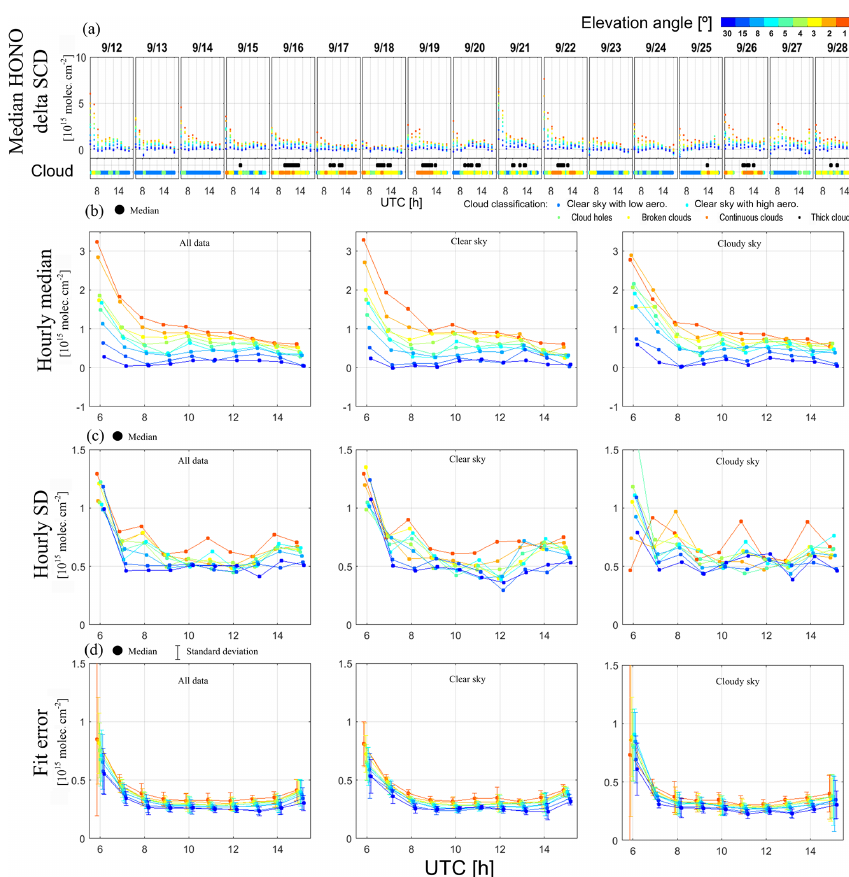
Figure 2. Overview of the HONO delta SCDs retrieved from all MAX-DOAS instruments using the “sequential FRS” during the whole CINDI-2 campaign period. (a) Time series of median HONO delta SCDs derived from measurements of all MAX-DOAS instruments by individual groups. The results of the cloud classification algorithm (applied to the “MPIC” measurements) are shown at the bottom of the subfigures. The colours indicate the elevation angles and cloud categories, respectively. The colours in (b) , (c) , and (d) indicate elevation angles as shown in the upper panel of (a) . (b) Diurnal variations of hourly median HONO delta SCDs derived from all MAX- DOAS instruments. (c) Diurnal variation of hourly standard deviations of differences from median HONO delta SCDs from all MAX-DOAS instruments. (d) Hourly median and standard deviations of the DOAS fit errors of the HONO delta SCDs from all MAX-DOAS instruments. The left, centre, and right columns of subfigures represent the results for all the data as well as results for “clear-sky” and “cloudy-sky” conditions,